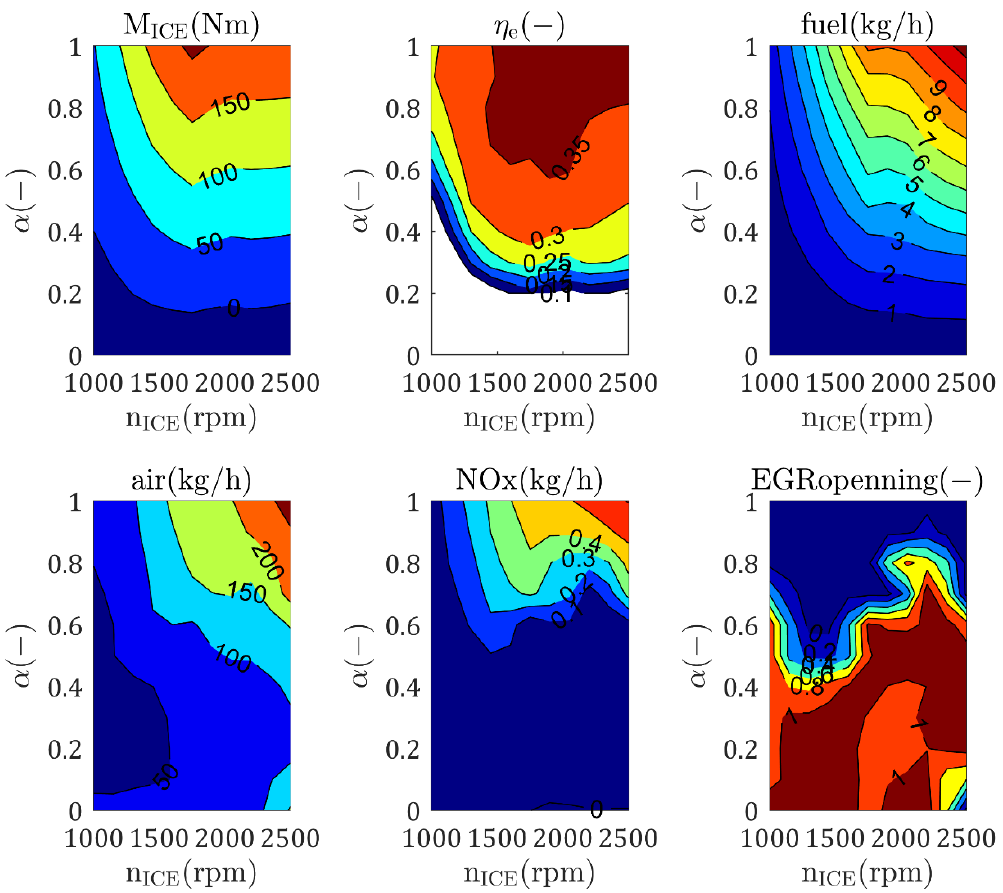
Figure 5. Maps of engine parameters.